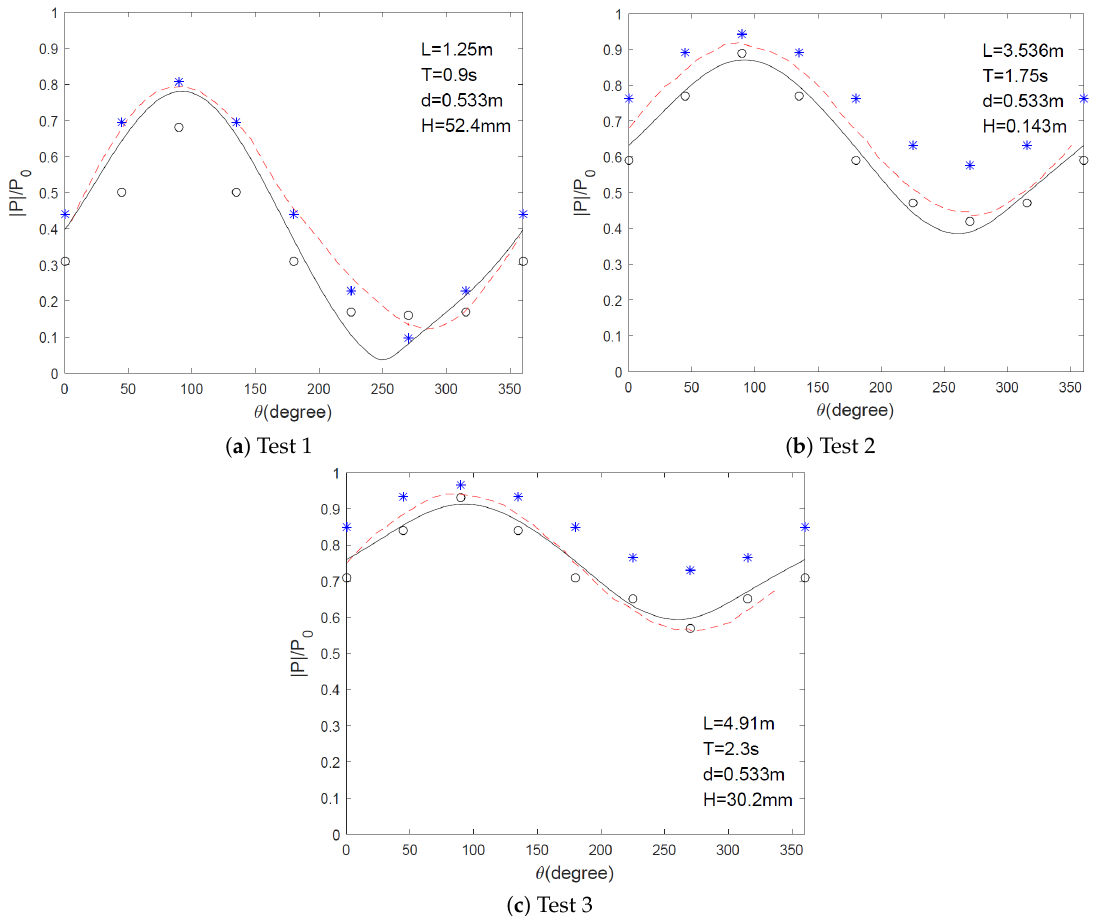
Figure 5. The wave-induced pore pressure in the vicinity of a fully buried pipeline. (red dashed line: numerical results of Cheng and Liu [7]; blue star: FEM results by COMSOL model [41]; circle line: experimental data [39]; solid line: present